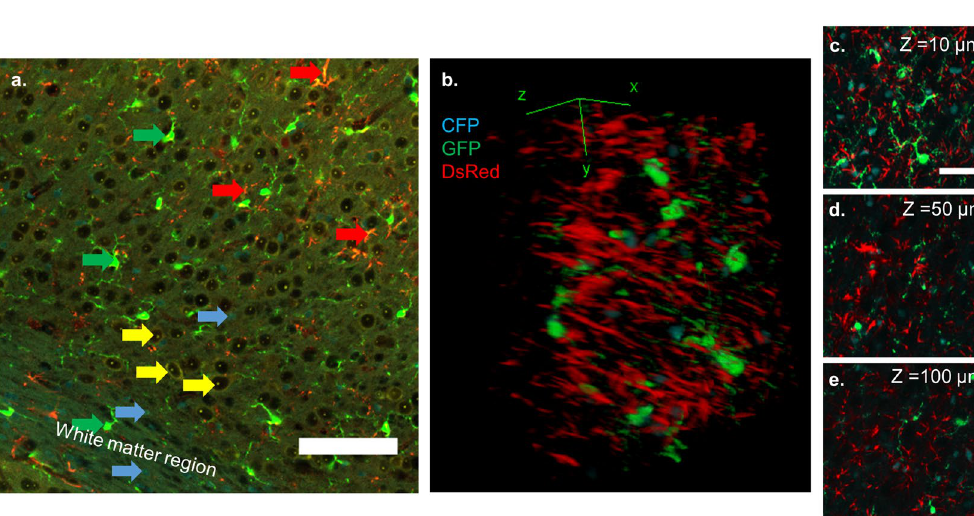
Figure 6. Retention of endogenous fluorophores in PrismPlus mouse brain tissue after CLARITY. ( a ) Confocal image (snapshot) of a cortex after active CLARITY showing that all fluorophores survived the clearing process. Note that YFP signal is prominent at the nucleolus and the nuclear envelope. Same colored arrow pointing at a particular cell type; Cyan arrow: CFP expressing oligodendrocytes, Green: GFP expressing microglia; Yellow:YFP expressing neurons, and Red: DsRed expressing astrocytes. ( b ) 3-D render view of 100 microns thick Z- stack of a PrismPlus brain (approximately layer IV-V in cortex) after CLARITY showing CFP expressing oligodendrocytes, GFP expressing microglia and DsRed expressing astrocytes. Figures C,D, and E represent 10 microns thick Z-stack projection at different Z-depths in Fig. B. Due to the punctate YFP, it was excluded in the Figures b,c,d, and e. Image in ( b ) was taken with a 20x objective with digital zoom of 2.0. Scale bar in a = 100 µ m; c = 50 µ